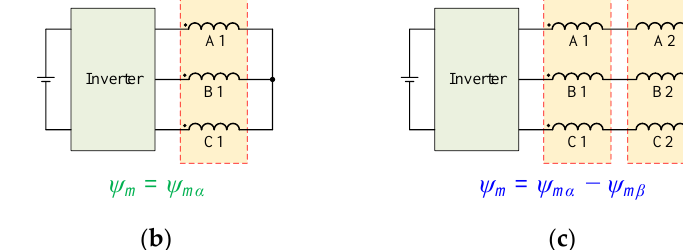
Figure 4. The resultant winding configurations of the WS circuit type II. ( a ) T2M1. ( b ) T2M2. ( c ) T2M3.